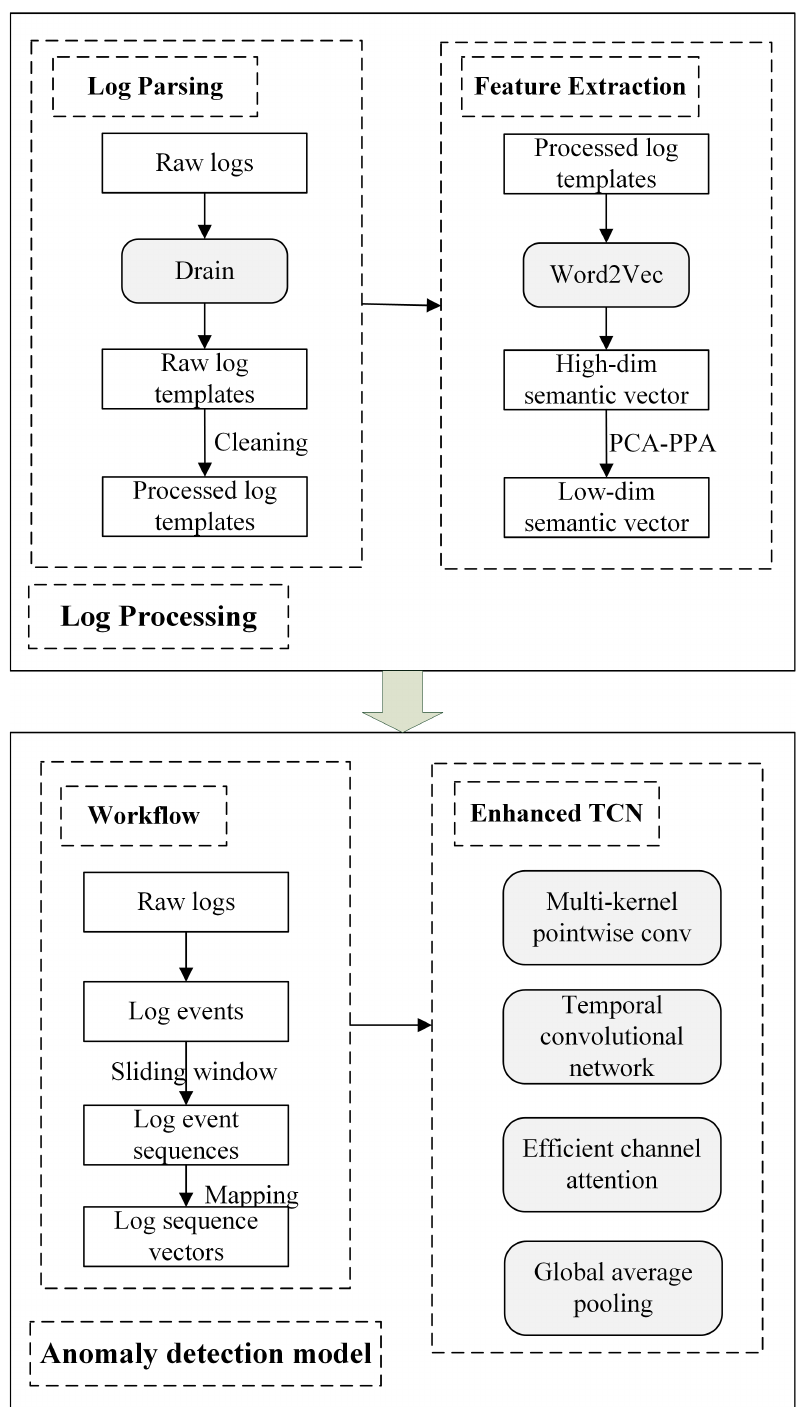
Figure 2. ETCNLog